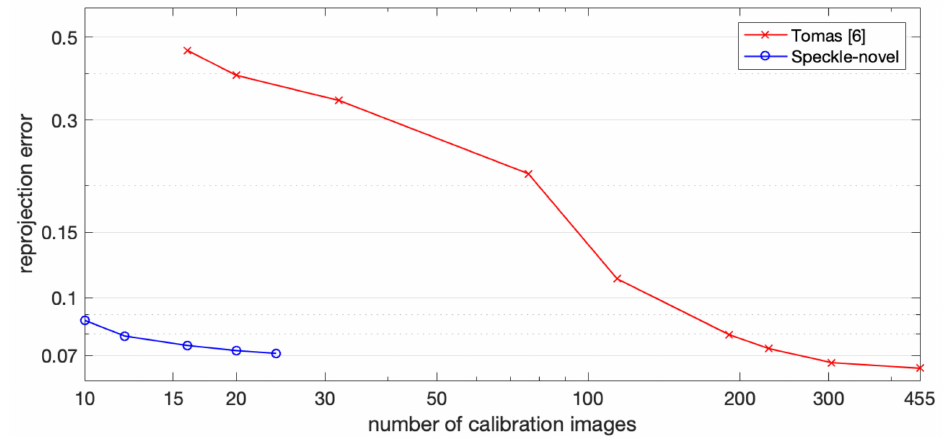
Figure 13. Reprojection error of Thomas S. et al.’s method and our point-to-point distortion calibration method on test set when different numbers of calibration images are